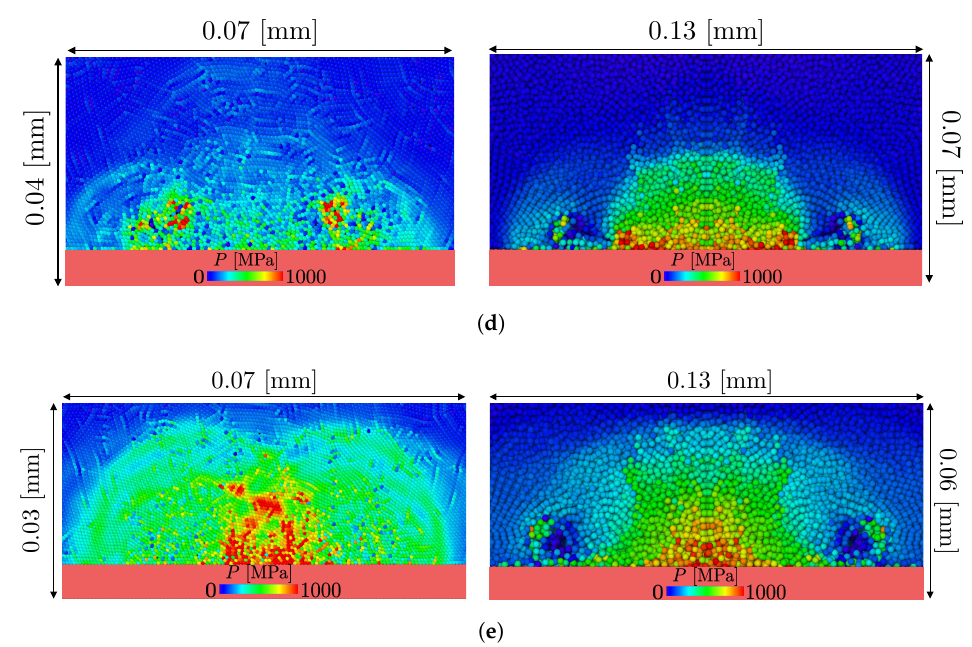
Figure 10. Pressure field for 2D [1] (left side) and 3D (right side) SPH model for a non symmetrical Rayleigh collapse ( dL / R 0 = 133, γ = 0.6 & P ∞ = 50 MPa): ( a ) Water hammer impact of the jet with the surface. ( b ) Lateral jet formation. ( c ) Lateral jet impact with the cavity sides and side shock formation. ( d ) Inner high pressure shock generation. ( e ) Second pressure peak generated by the travelling inner